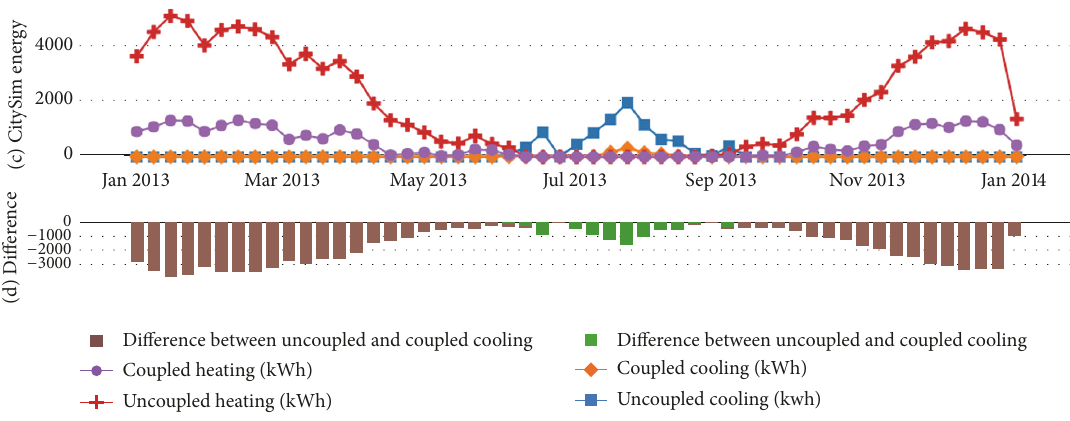
Figure 2: A sample output of CitySim (Source: https://plot.ly/ ∼